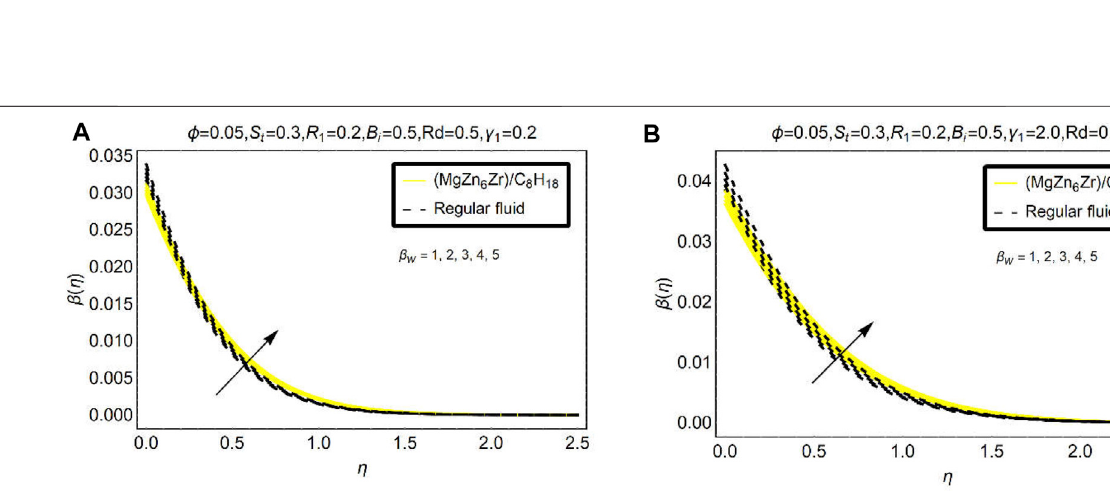
FIGURE 13 | Temperature via β w (A) γ 1 (cid:2) 0 . 2 and (B) γ 1 (cid:2) 2 .